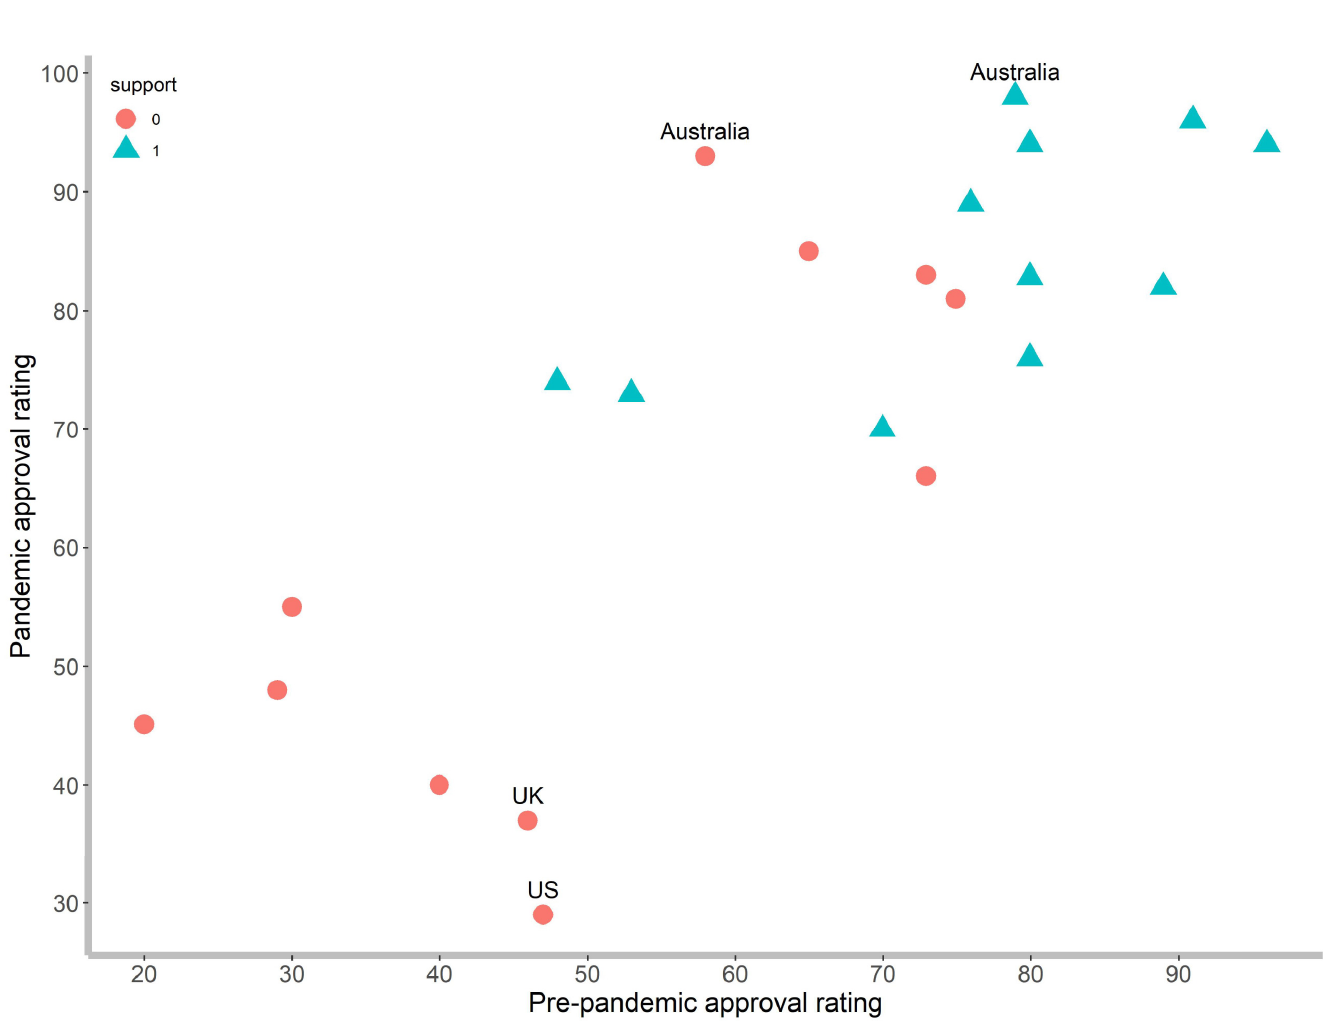
Fig 3. Scatter plot of pandemic approval ratings and pre-pandemic approval ratings, {Y i , X 1 }, by governing party supporters (1) and non-supporters (0).